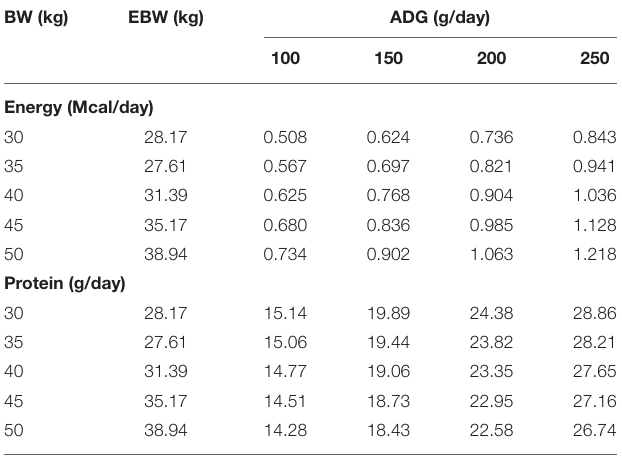
TABLE 4 | Net energy and protein requirements for weight gain in intact male Dorper × Santa Ines lambs from 30 to 50kg BW.